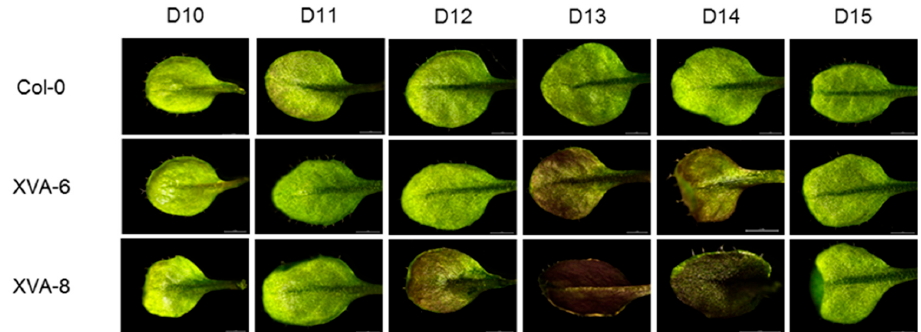
Figure 3. Leaf color changes in transgenic XVA ‐ PtrMYB119 Arabidopsis by 10 ppm DHT treatment. The seeds were germinated on 1/2 MS agar medium in the presence of 10 ppm DHT and grown for 15 days. Leaf color change was examined daily after seed germination (D: day).